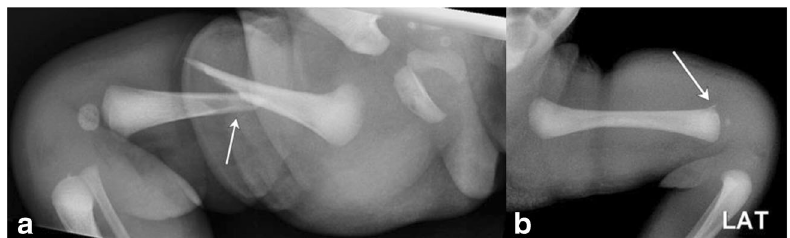
Fig. 18 Femur fractures Frontal radiograph of the lower extremity in a 1-day-old infant (a) demonstrates displaced an oblique mid- shaft fracture of the right femur. This was a consequence of ex- cessive traction on the femur. Lateral radiograph of the femur (b) in another 1-day-old breech infant demonstrates irregularity at the